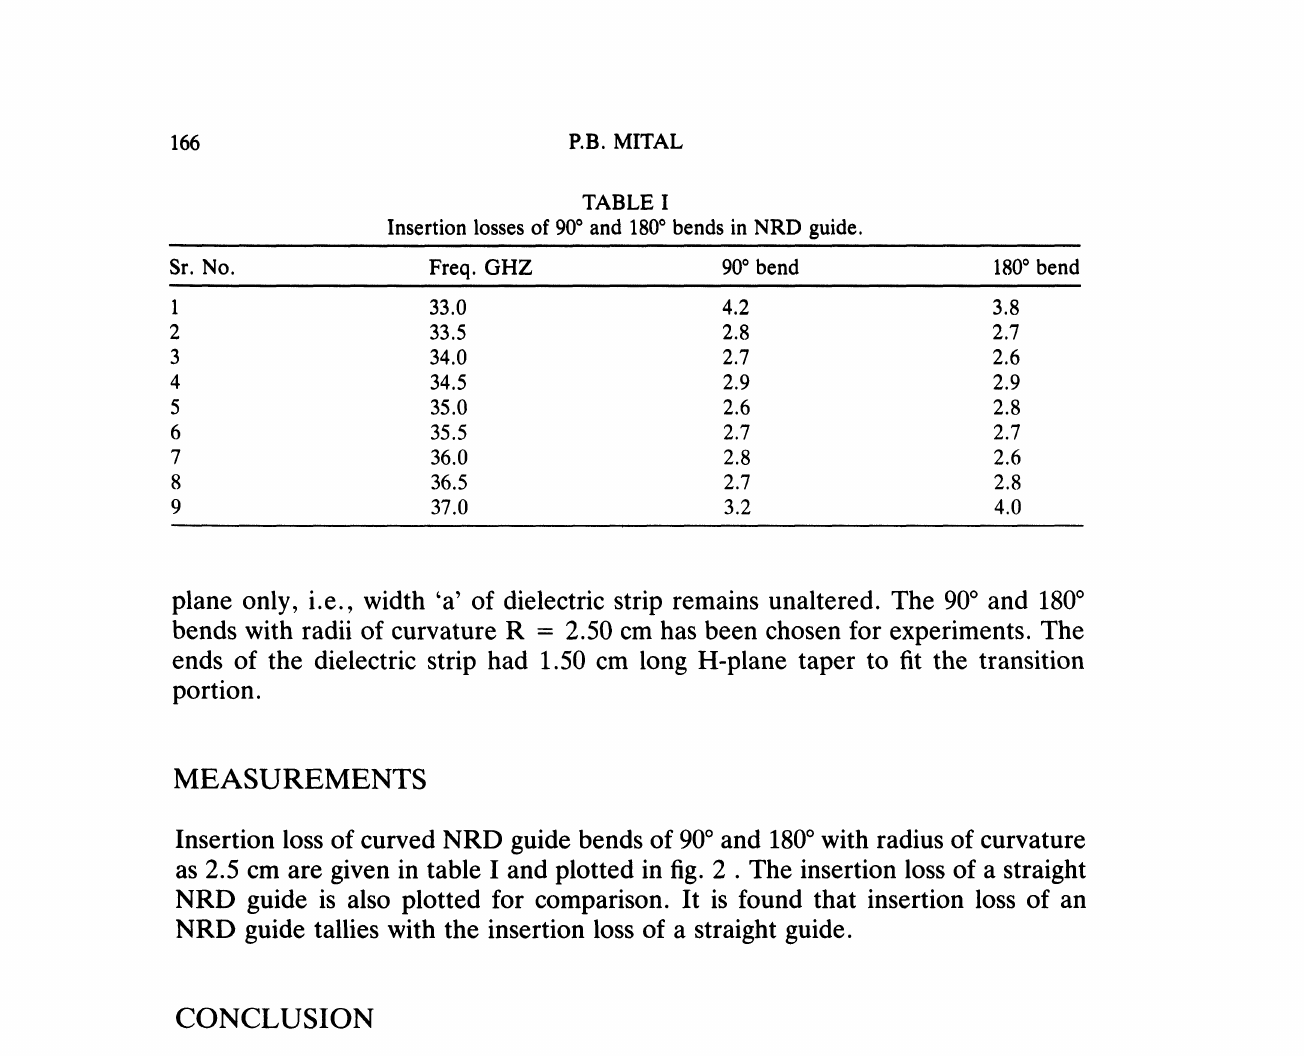
Insertion losses of 90 and 180 bends in NRD guide. Sr.